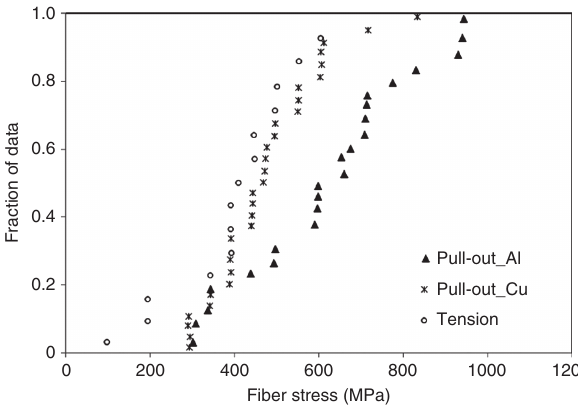
Figure 10 Probability plots of stress level in tension and pull-out tests of pseudoelastic fibers.